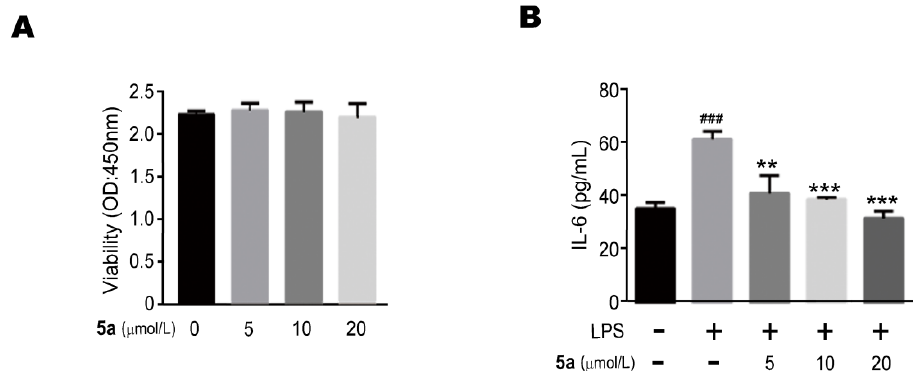
Figure 5. Compound 5a increased the effects of the pro-inflammatory cytokine IL-6. RAW264.7 cell proliferation in response to compound 5a at different doses assayed by CCK-8 assay ( A ). Compound 5a suppressed LPS-induced IL-6 expression in RAW 264.7 cells. The cells were pretreated with different concentrations of compound 5a for 2 h and then stimulated with 1 µ g/mL LPS for 4 h. Culture media were collected in order to measure IL-6 concentrations using an ELISA kit. Data represent mean ± SEM values of three experiments. ** p < 0.01 and *** p < 0.001 compared with LPS alone. ### p < 0.001 compared with DMSO alone ( B ).